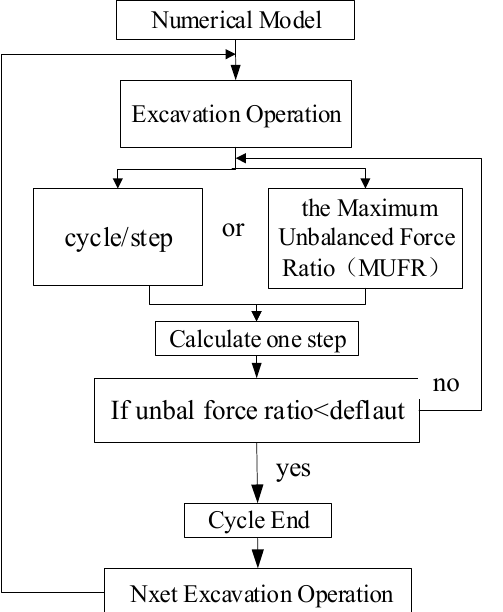
Figure 8. The procedure of continuous excavation in the numerical modeling.